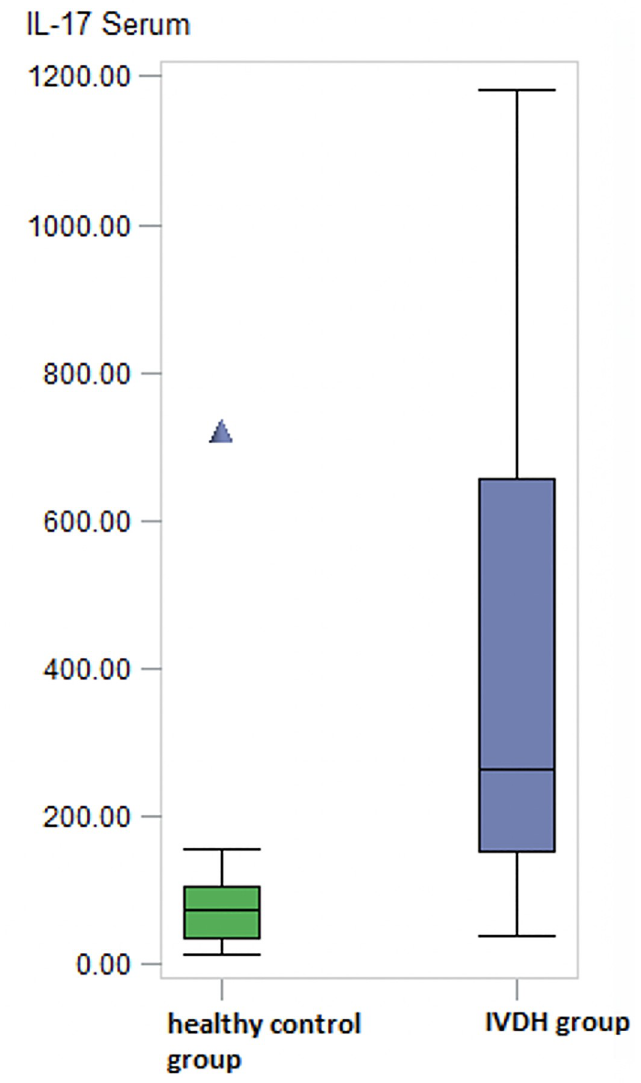
Fig 5. IL 17 levels in serum. Significantly higher levels of IL-17 pg/ml measured in serum preoperatively of dogs suffering from IVDH in comparison to healthy controls (p < 0.01). Sample number: Healthy control group: n = 10; IVDH group: n = 23. IVDH = intervertebral disc herniation; IL-17: Interleukin-17; pg/ml: picogram/milliter.